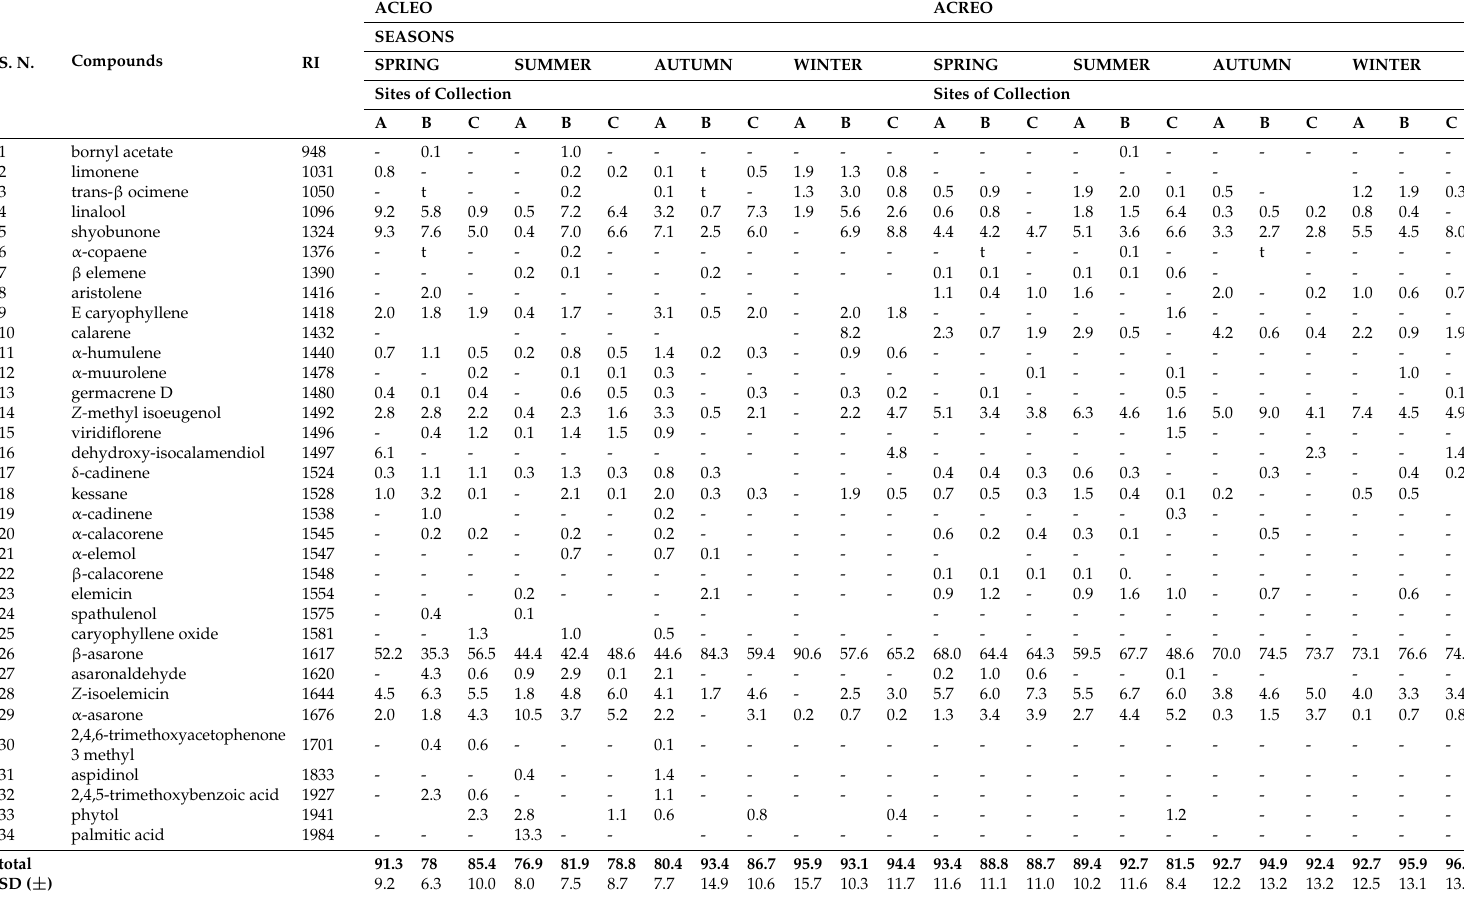
Table 1. Comparative chart on seasonally GC/MS analysis of Acorus calamus leaves and rhizome essential